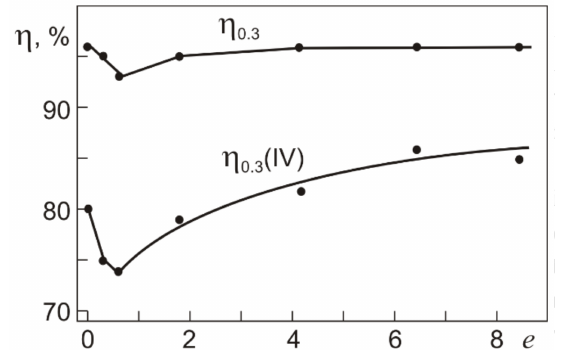
Figure 11. The degree of shape recovery η 0.3 at τ 0.3 and η 0.3 (IV) at τ 0.3 (IV) in Ti 49.8 Ni 50.2 in isothermal loading–unloading cycles (295 K) with heating in unloaded states (500 K) as a function of the true strain e in warm abc